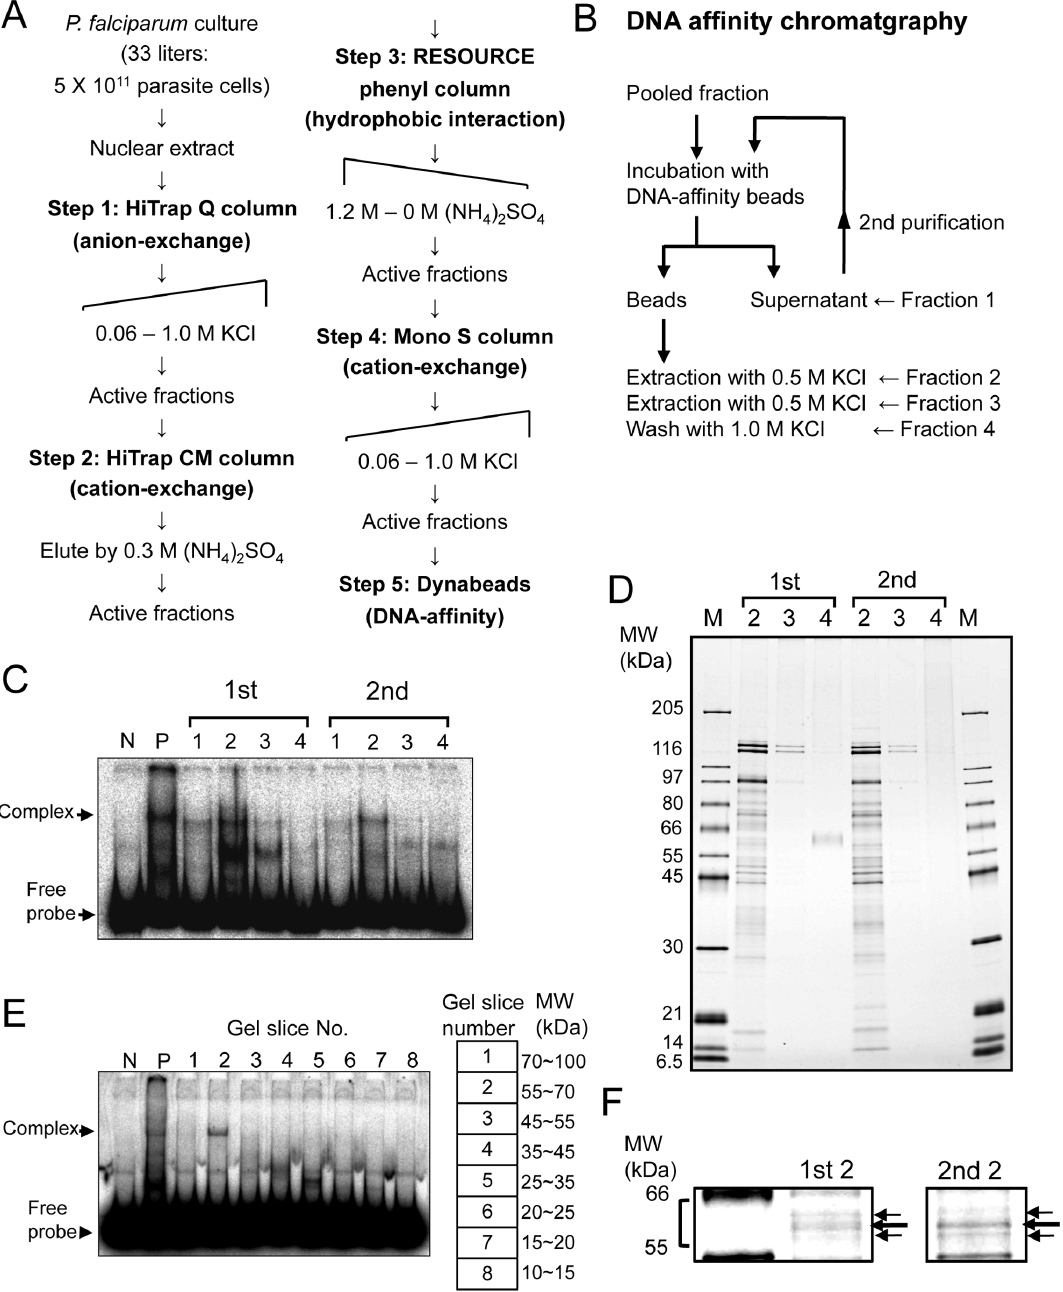
Figure 1. Purification of PREBP. (A) Scheme for purification of PREBP from parasite nuclear extract by 5 chromatography steps. (B) Detailed scheme of the final DNA-affinity chromatography step. (C) EMSA of each elution and washing fraction obtained from DNA-affinity purification. The number of the fraction corresponds to the purification scheme shown in Figure 1B. 0.1 m l of each fraction and the 32 P-labeled PRE probe were used for the EMSA. Lanes N and P indicate the negative control (probe only) and positive control (assay with the 0.6 m g of parasite nuclear extract). Positions of the free probe and the shifted band are indicated on the left. (D) SDS-PAGE and silver staining of the PRE affinity-purified fractions. 0.5 m l of each PRE-purified fraction was separated on SDS-PAGE and proteins were visualized by silver staining. Molecular mass markers are indicated in kDa on the left. (E) Estimation of the molecular size of PREBP. A partially purified PREBP fraction was applied to an SDS-PAGE. Gel pieces were cut from the gel according to the 8 grades of molecular weight. The range of molecular weight of each gel piece is shown in the right panel. The proteins were eluted from each gel piece and renatured. The PRE-binding activity of the each renatured fraction was checked by EMSA (left panel). (F) Probable candidate bands observed in the final fractions. The 3 candidate bands were indicated with arrows.